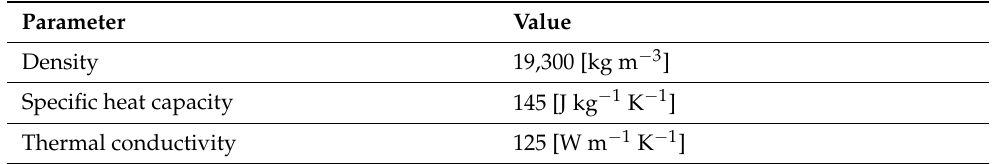
Table 3. Tungsten thermo–physical properties.